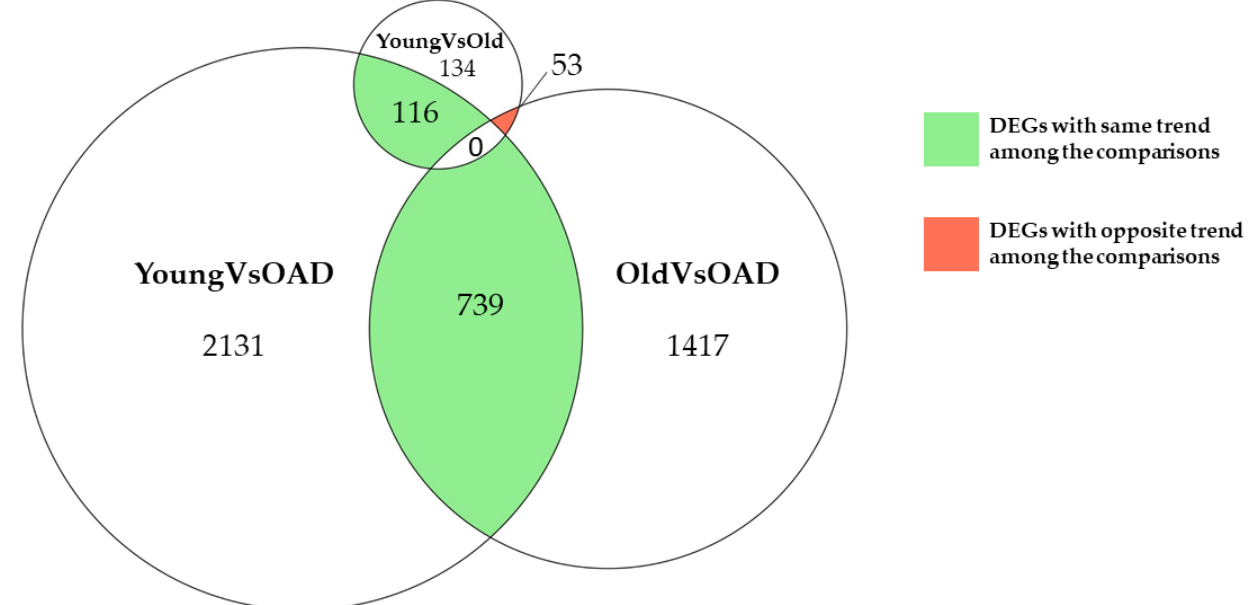
Figure 1. Venn diagram distribution of DEGs between Young, Old, and OAD groups. Green represents all the DEGs that have the same trend among the different comparisons. Conversely, red represents the DEGs that have the opposite trend among the comparisons. Numbers under the name of comparisons are related to the DEGs found exclusively in that comparison.